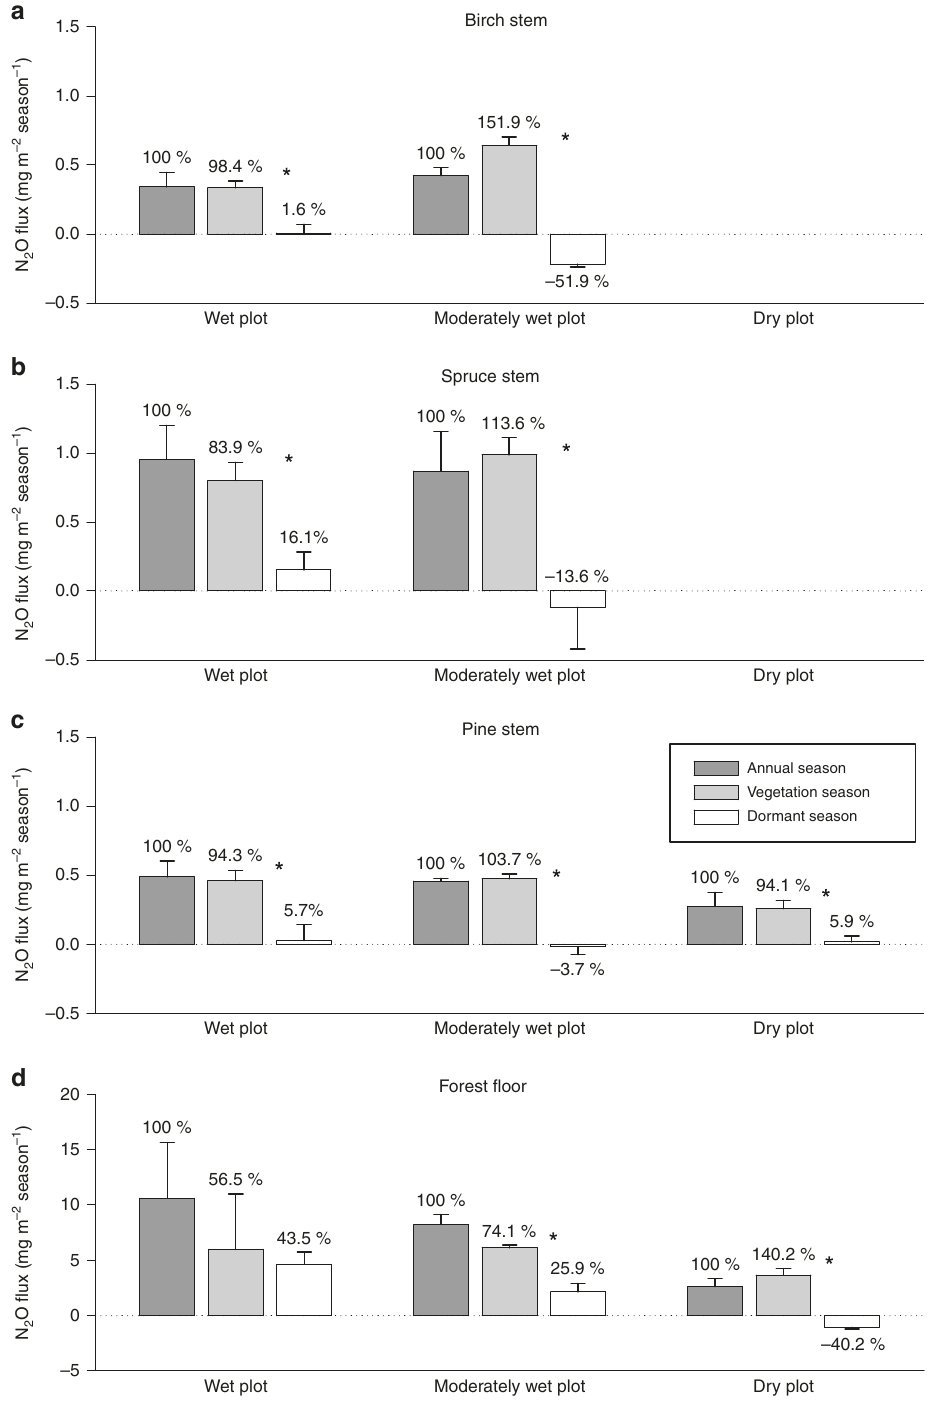
Fig. 5 Seasonal N 2 O fl uxes in tree stems and forest fl oor. N 2 O fl uxes in stems of birch ( a ), spruce ( b ), and pine ( c ), and in forest fl oor ( d ) are presented at annual scale (black columns), for vegetation season (March – September, grey columns), and for dormant season (October – February, white columns). The fl uxes (means ± standard error) are sums of N 2 of 2 O exchanged over one year, vegetation season, or dormant season, respectively, and expressed per m stem or soil surface area. Positive fl ux values indicate N 2 O emission, negative values N 2 O uptake. Mean annual volumetric water contents ( ± standard error) of the plots were as follow: wet plot, 0.81 ± 0.02 m 3 m − 3 ; moderately wet plot, 0.40 ± 0.02 m 3 m − 3 ; and dry plot, 0.21 ± 0.01 m 3 m − 3 . The dry plot did not have spruce or birch trees. Stem fl uxes were measured from three trees per species at each plot ( n = 3). Forest fl oor fl uxes were measured at three positions at the wet and moderately wet plots ( n = 3) and at six positions at the dry plot ( n = 6). Statistically signi fi cant differences between fl uxes over vegetation and dormant season at p < 0.05 are indicated by asterisks. The percentage contributions of fl uxes over the vegetation and dormant season to the annual fl uxes (de fi ned as 100%) are indicated above the